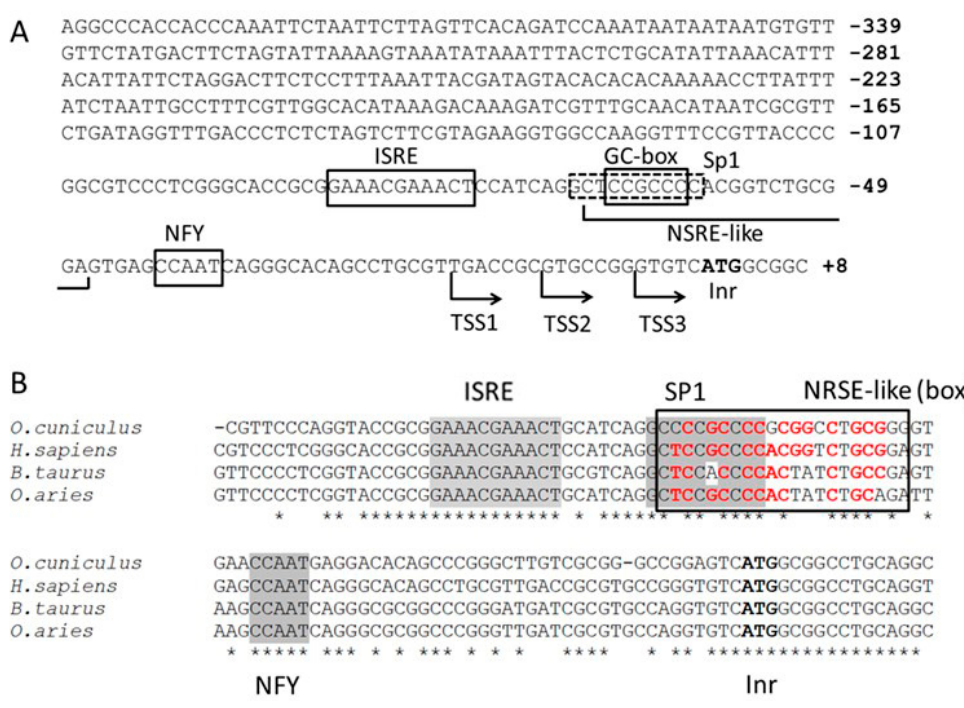
Figure 1. Putative motifs of the human PNPT1 promoter and its conservation across species. ( A ) Nucleotides 4692 to 5095 of NG_033012.1 NCBI Reference sequence were analyzed with MatInspector (Genomatix) and Promo (Alggen) online applications. ISRE, GC-box and NFY binding site are highlighted with solid boxes, and putative SP1 binding site with a dotted box. NSRE-like sequence is underlined, and initial ATG (Inr) is shown in bold. Previously reported Transcription Start Sites (TSS) are shown. ( B ) Nucleotides 4984 to 5103 of NG_033012.1 NCBI Reference sequence corresponding to the human ( H. sapiens ) PNPT1 promoter were aligned with homologous sequences of rabbit ( O. cuniculus ), cow ( B. taurus ) and sheep ( O. aries ), using Clustal Omega software (EMBL-EBI) with default settings. Animal sequences were previously retrieved with the Ensembl Genome Browser by means of a BLAST search using the human sequence as query. Nucleotides matching INRS, SP1 and NFY binding consensus sequences are shown with grey background. NRSE-like sequences are shown boxed, and nucleotides matching the reported NSRE consensus sequences are highlighted with red bold characters. Asterisks indicate nucleotides conserved in the four sequences.